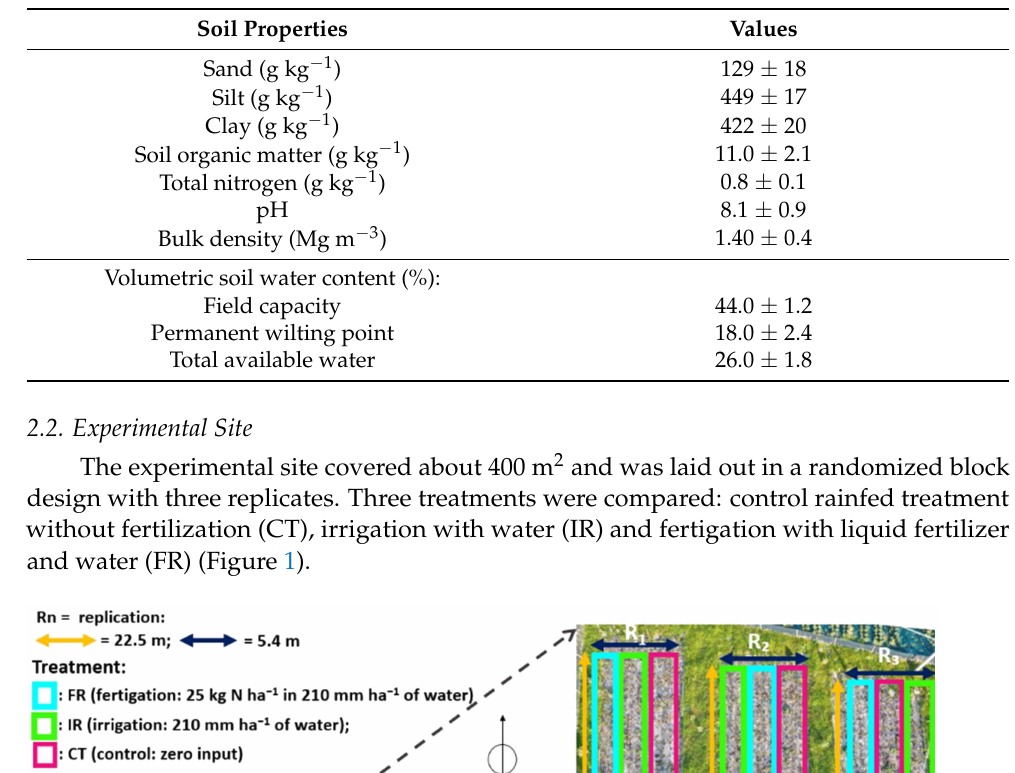
Table 1. Soil properties in the 0–30 cm layer in the experimental plots in 2020–2021.